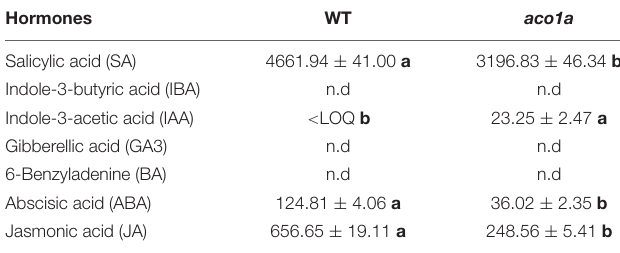
TABLE 2 | Hormone concentrations ng/mL